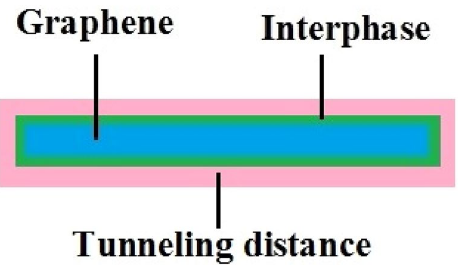
Figure 1. Schematic of graphene, interphase and tunneling regions in a nanocomposite.